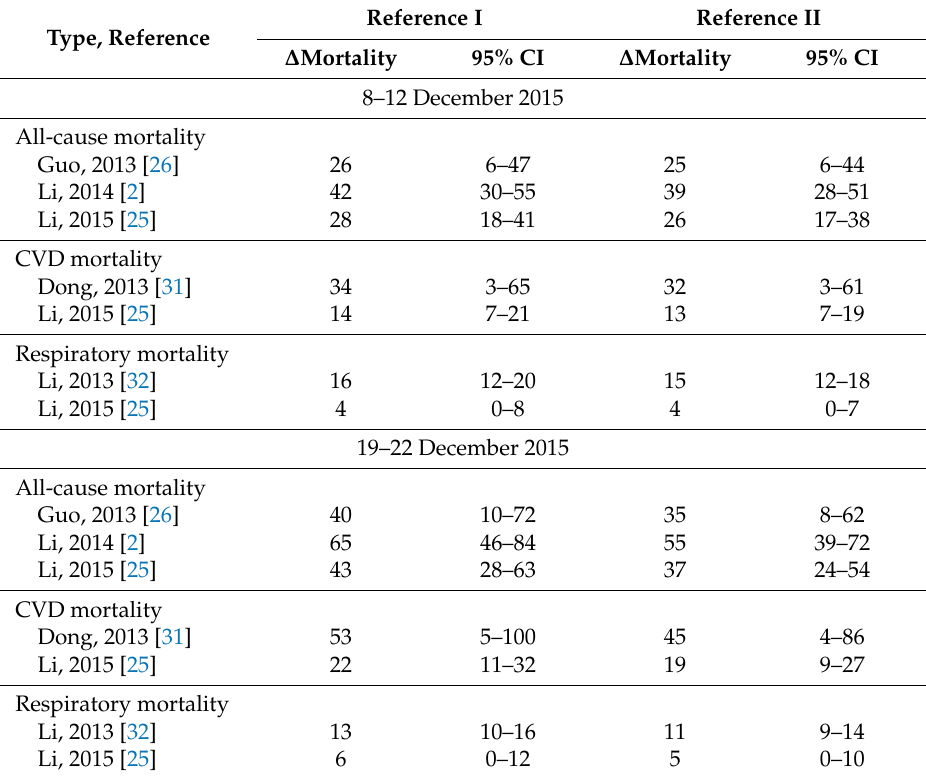
Table 2. Estimated excess mortality due to the severe smog events declared as the red-alert periods (8–12 and 19–22 December 2015) in